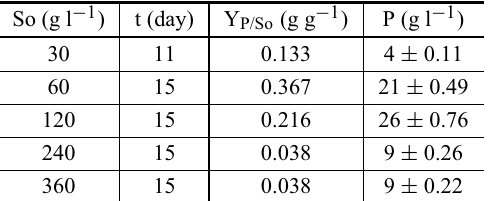
Kojic acid data production related to different sucrose concentrations. Y: yield coefficient of product formation, So: initial concentration of substrate, t: time (day) and P: maximum production of